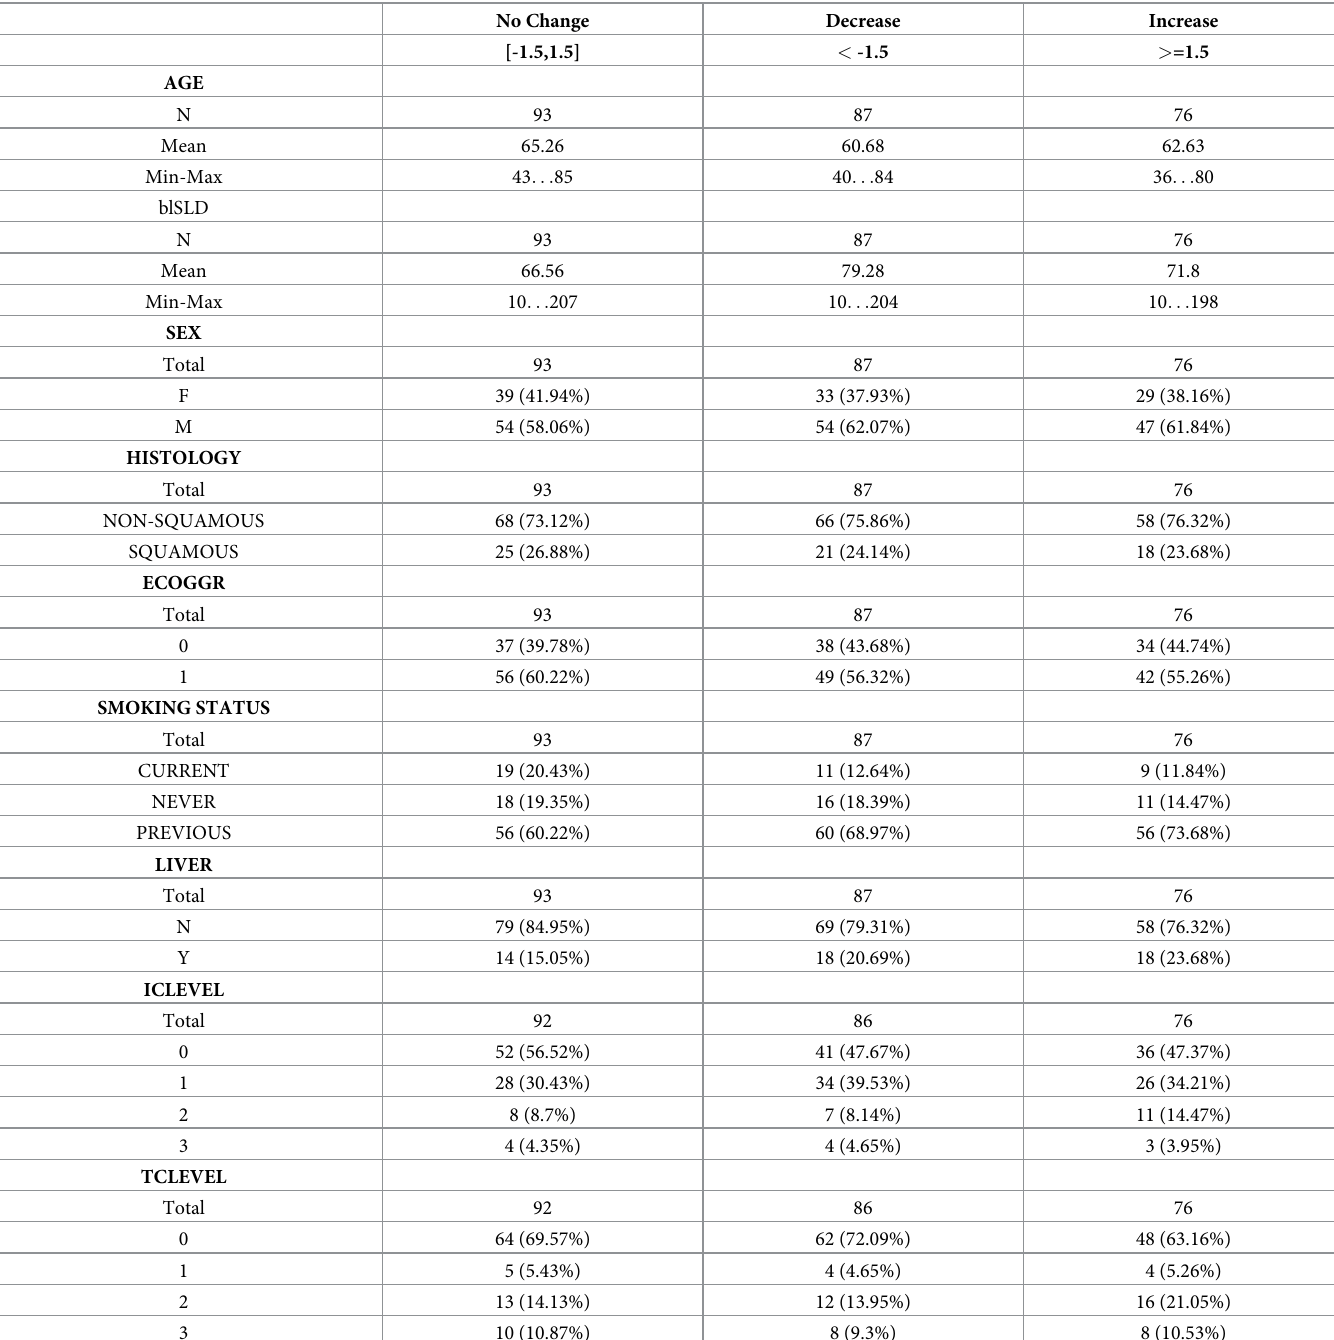
Table 3. Patient demographics and clinical characteristics in the three CRP fold change buckets for docetaxel in